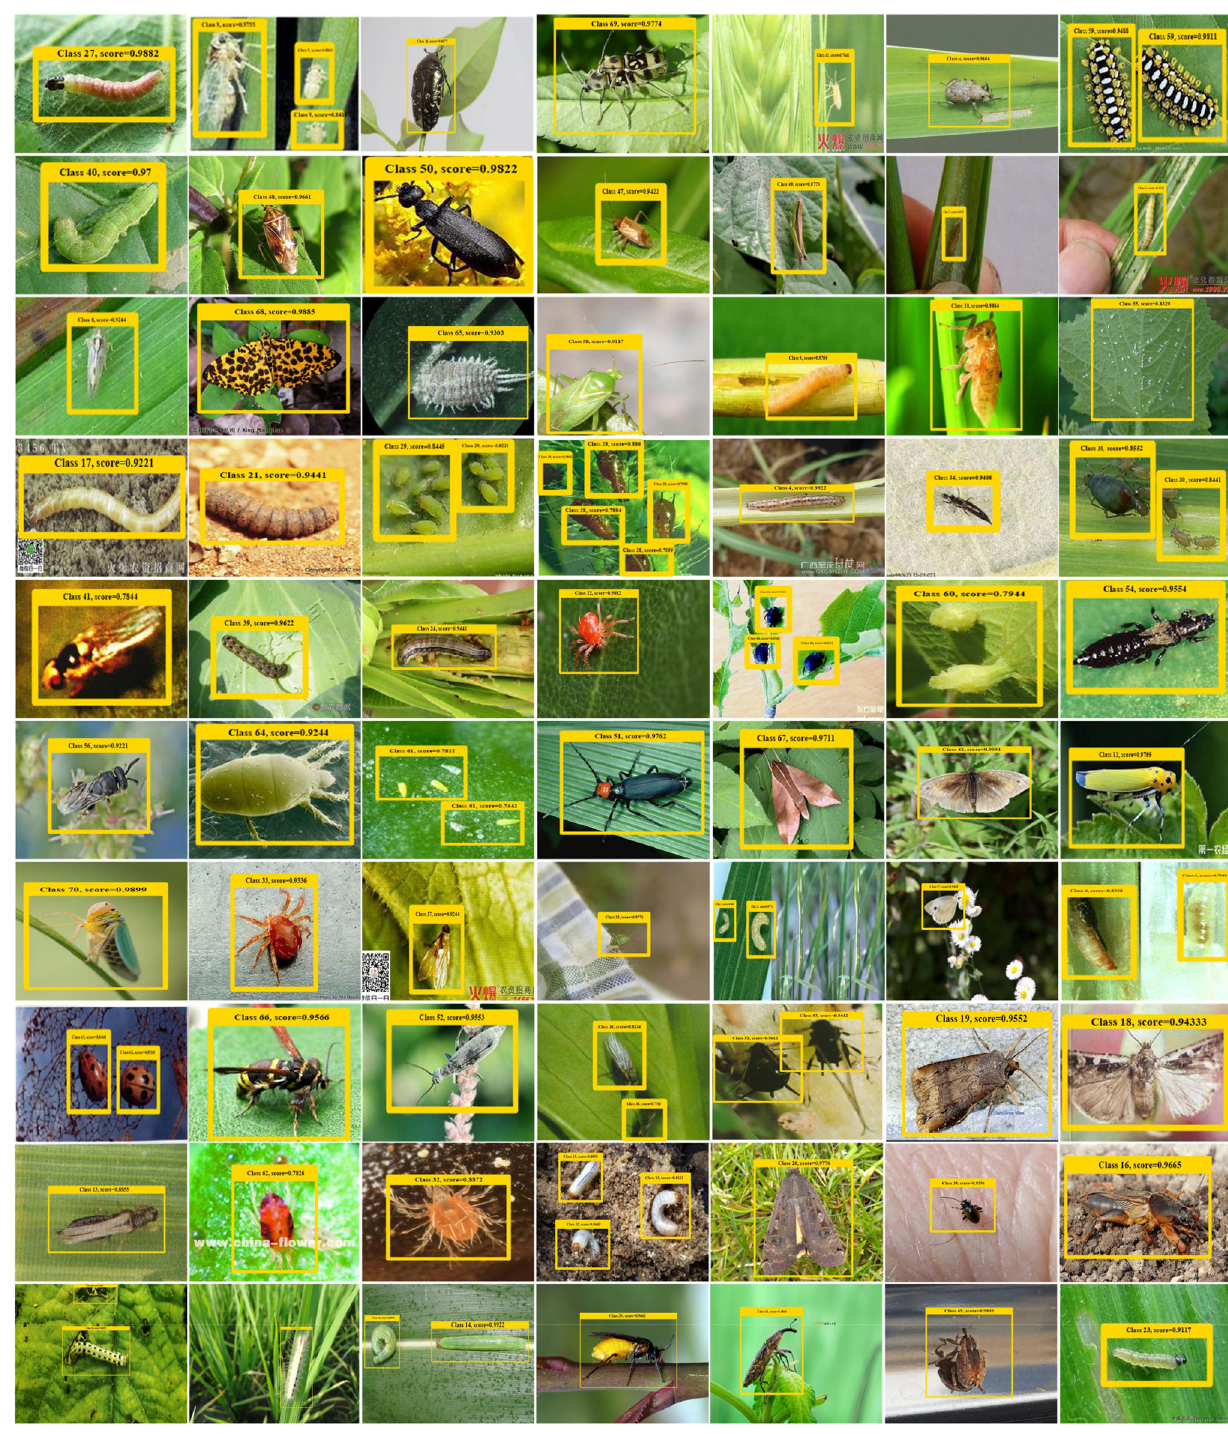
Fig. 5 Sample detection results of insect pests using the proposed